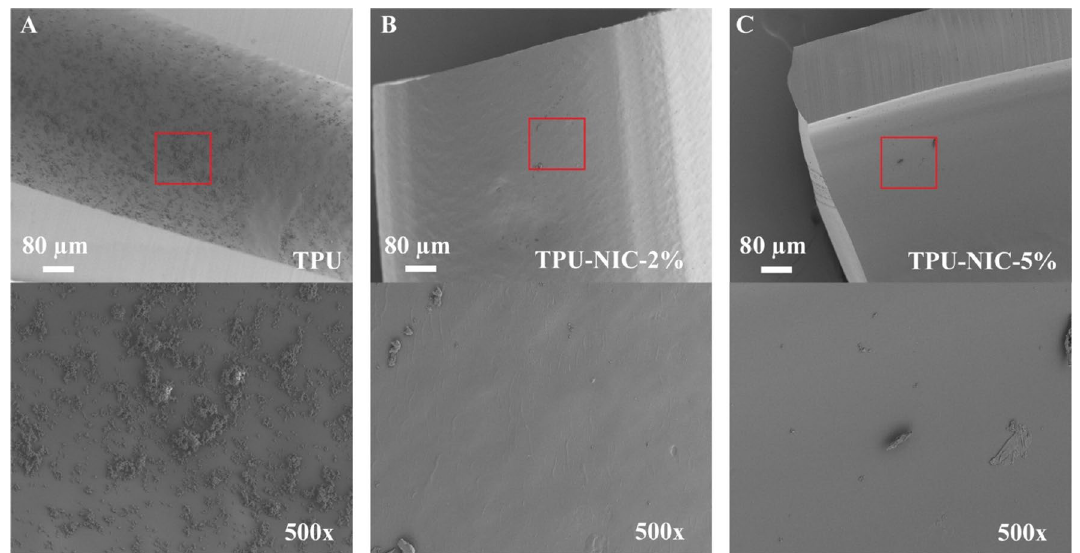
Figure 7. ( A – C ) Representative SEM images of 24 h biofilm formation of MSSA on catheter surfaces. Low magnification (top row, 100 ×) and higher magnification views (bottom row, 500 ×) of longitudinally sectioned catheter segments showing intraluminal bacterial colonization of TPU ( A ) and TPU loaded with 2 and 5% of NIC ( B , C observed after 14 days when the bacterial load was greatly reduced (~ 5.7 Log CFU reduction p < 0.0001) on both NIC loaded catheters which was in line with further bacterial reduction of ~ 4.2 Log CFU (p < 0.0001) in corresponding surrounding tissue (Fig. 8A,B). In a subsequent experiment, mice implanted with catheter segments loaded with 2 and 5% of NIC were chal- lenged with the MRSA strain (Fig. 8C,D). On day 1 after infection, the bacterial load on 2 and 5% NIC catheters (4.29 and 3.40 LogCFU/catheter; p < 0.001 and p < 0.0001, respectively) was significantly lower if compared to unloaded catheters (6.06 LogCFU/catheter). Moreover, bacterial counts in the surrounding tissue of 5% NIC catheters was significantly reduced by a value of 1.23 LogCFU (p < 0.01), as similarly observed with the MSSA strain. On the following days, the bacterial burden on both NIC loaded segments and in the surrounding tissue gradually decreased over time until day 14 (Fig. 8C,D). Few colonies of 2 and 5% NIC groups, isolated at day 14, showed increased MIC values for NIC (2 colonies = MIC 1 µg/mL, 1 colony = MIC 2 µg/mL, and 1 colony = MIC 8 µg/mL). The MIC recorded for the original strain was replicated for most of the isolated colonies ( i.e. 56 colonies MIC 0.25 µg/mL). Finally, no increase in terms of MIC values of NIC was observed in colonies isolated from non-loaded TPU groups. Histology of tissue surrounding the catheters was performed on tissue samples from mice infected with MSSA and sacrificed on day 3 (Fig. 8E). In mice implanted with non-loaded catheter segments in absence of infection (control group), the inflammation reaction was characterized by a small number of neutrophils and macrophages, with minimal fibrin deposition restricted to peri-catheter tissue. In addition, no necrosis was observed in this group (Fig. 8E-1). On the other hand, in biopsies from mice with infected non-loaded catheter segments, the inflammation was characterized by the presence of abundant neutrophils and less macrophages which were embedded in abundant edema and fibrin. Extensive necrosis was observed around the catheter segments, vari- ably extending into the surrounding tissues. Moreover, a full-thickness coagulative skin necrosis was observed in this group (Fig. 8E-2). Intralesional bacterial biofilm formation was observed within the necrotic debris that surrounded the catheter segment. Additionally, features such as epidermal hyperplasia, furunculosis and skin ulceration were registered in the tissue. Animals with NIC-loaded catheter segments showed morphological changes similar to those present in the infected mice with non-loaded catheters, however the severity was not as marked. Additionally, in the same biopsies, we observed a moderate number of neutrophils and macrophages with moderate fibrin deposition. Furthermore, a minimal number of necrotic debris was found in the surround- ing tissue and no bacterial aggregates were observed, which agrees with the observed quantitative decrease in the bacterial load in surrounding tissue. The NIC distribution in situ in the surrounding tissue is shown in Fig. 8F. An initial NIC level of 407 ± 389 and 932 ng/g ± 922 of tissue was recorded in mice bearing catheter segments with 2 and 5% NIC, respectively. After 3 days, NIC levels of 781 ± 382 ng/g and 312 ± 206 ng/g (no significant difference between both groups) were recorded in the surrounding tissue of catheter segments loaded with 2 and 5% NIC, respectively. On the following experimental days, the in situ NIC concentration decreased in the surrounding tissue, reaching the lowest values of 65 ± 51 ng/g (NIC 2%) and 135 ± 62 ng/g (NIC 5%) on day 14. The in vivo level of NIC in plasma is shown in Fig. 8G. After 1 day, NIC plasma levels of 20 and 47 ng/mL were measured for catheters with 2 and 5% of NIC, respectively. On the consecutive time points, the NIC plasma levels for both NIC loadings gradually dropped over time, reaching levels at the limit of detection on day 14.